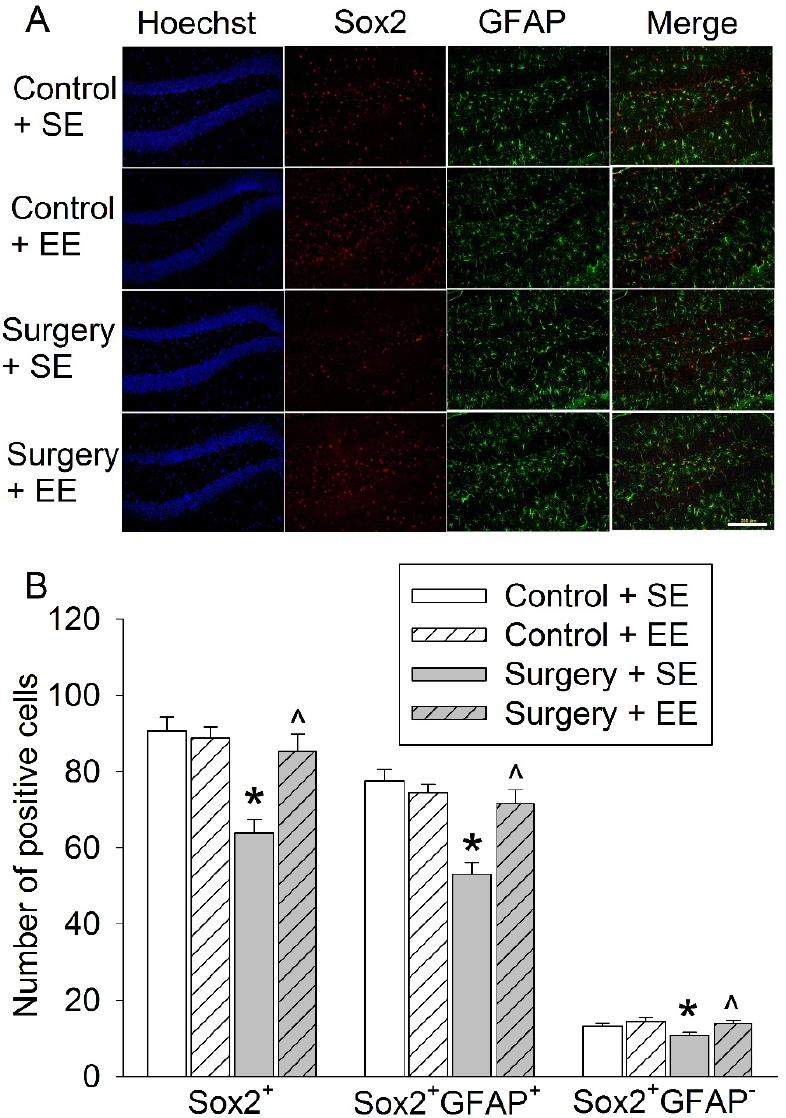
Figure 4. Effects of environmental enrichment and surgery on Sox2 expression in the hippocampus. Eighteen-month-old mice were subjected to right carotid artery exposure and environmental enrichment. Their brains were harvested 4 weeks after surgery. ( A ) Representative images of hippocampal dentate gyrus. Scale bar: 200 μ m. ( B ) Quantitative results. Results are means ± S.E.M. ( n = 6). * p < 0.05 compared with control, ^ p < 0.05 compared with surgery group.